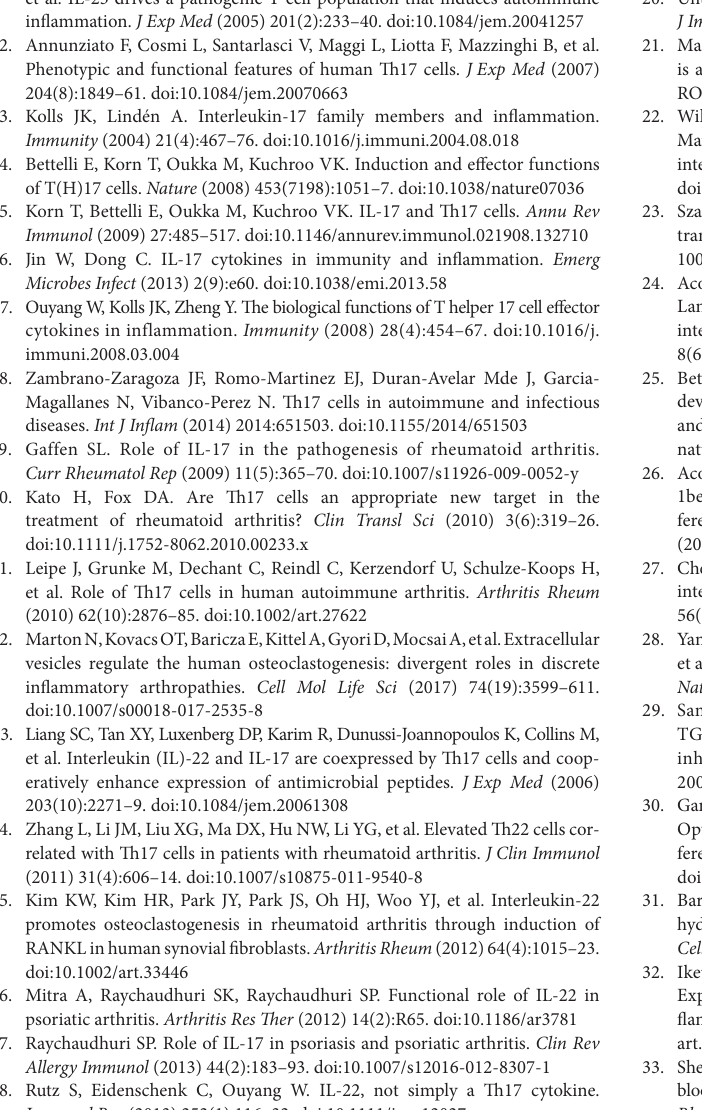
linear scale; the median, minimum, and maximum values are indicated (Wilcoxon signed rank test * p < 0.05). FigUre s4 | CCR6 + CCR4 + , CCR6 + CXCR3 + , and CXCR3 + chemokine receptor expression during differentiation. Healthy donor- [ (a) n = 6], rheumatoid arthritis (RA)- [ (B) n = 5], and psoriatic arthritis (PsA)- [ (c) n = 5] derived CD4 + CD45RO − naive T cells were stimulated and treated with different cytokine combinations to promote T-helper 17 cell differentiation from naive T cells as described earlier. Chemokine receptor expression was measured by flow cytometry on the fifth day. Relative chemokine receptor expression levels (compared to the naive untreated cells) are shown in a logarithmic scale; median, minimum, and maximum values of the normalized parameters were indicated (Friedman test and pairwise Wilcoxon signed rank test, * p < 0.05). FigUre s5 | Interrelation of IL-17A and IL-22 cytokine secretion during differentiation. IL-17A (a,B) and IL-22 (c,D) cytokine productions during T-helper